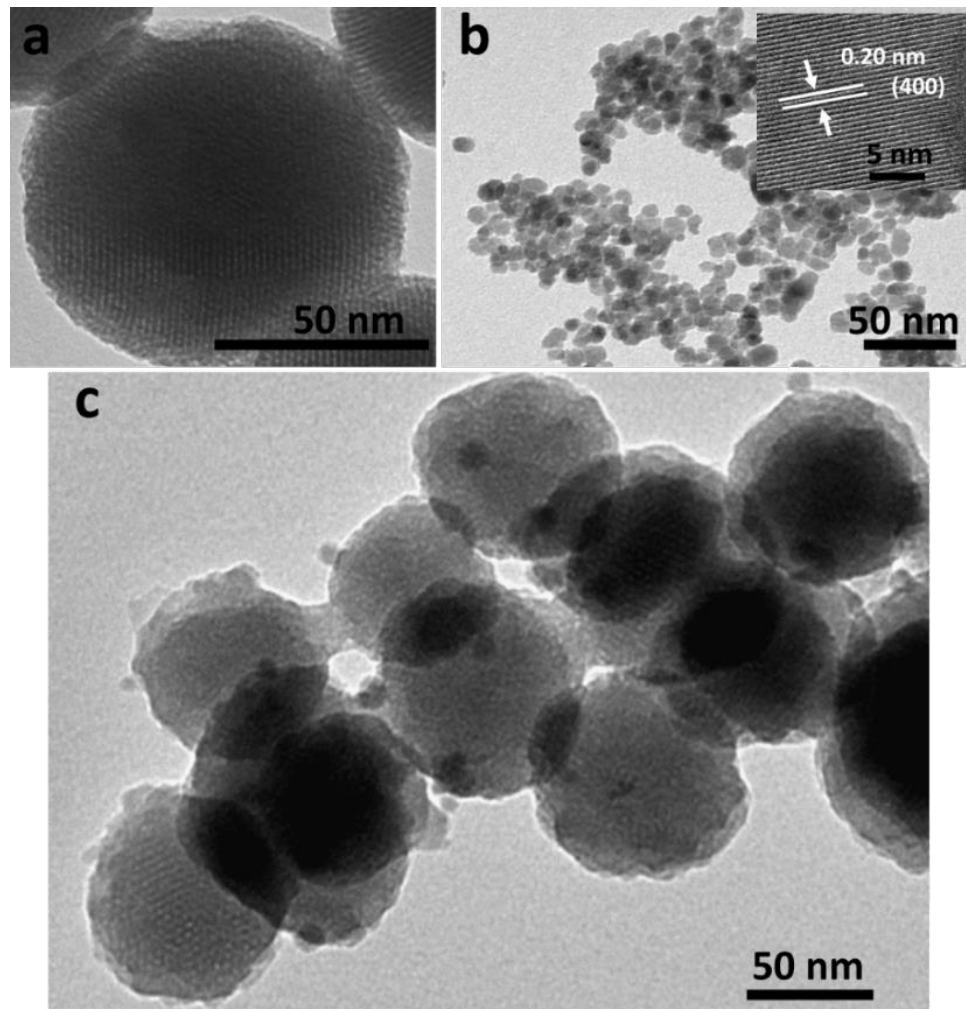
Figure 6. TEM micrographs of ( a ) MSNs, (b ) SPIONs@PDA with HRTEM image of a particle displaying lattice fringes with d-spacings of 0.20 nm, which is characteristic of the (400) of magnetite structure, and ( c ) MSNs@SPIONs@PDA.